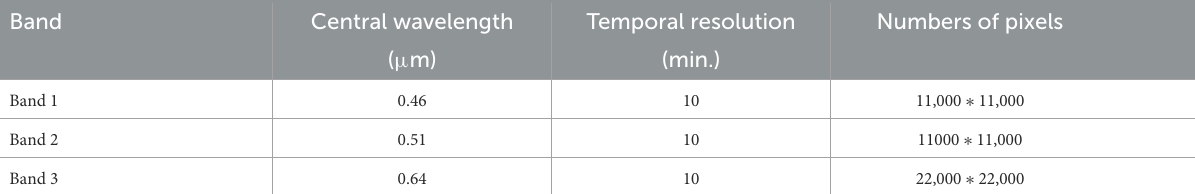
TABLE 2 Information of the Band 1, Band 2, and Band 3 of the Himawari-8 satellite. Band Central